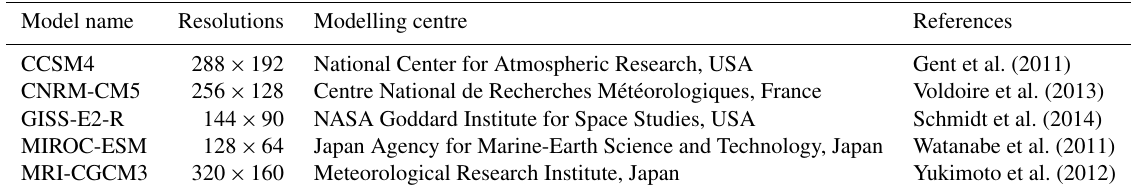
Table 1. PMIP3–CMIP5 models used in this